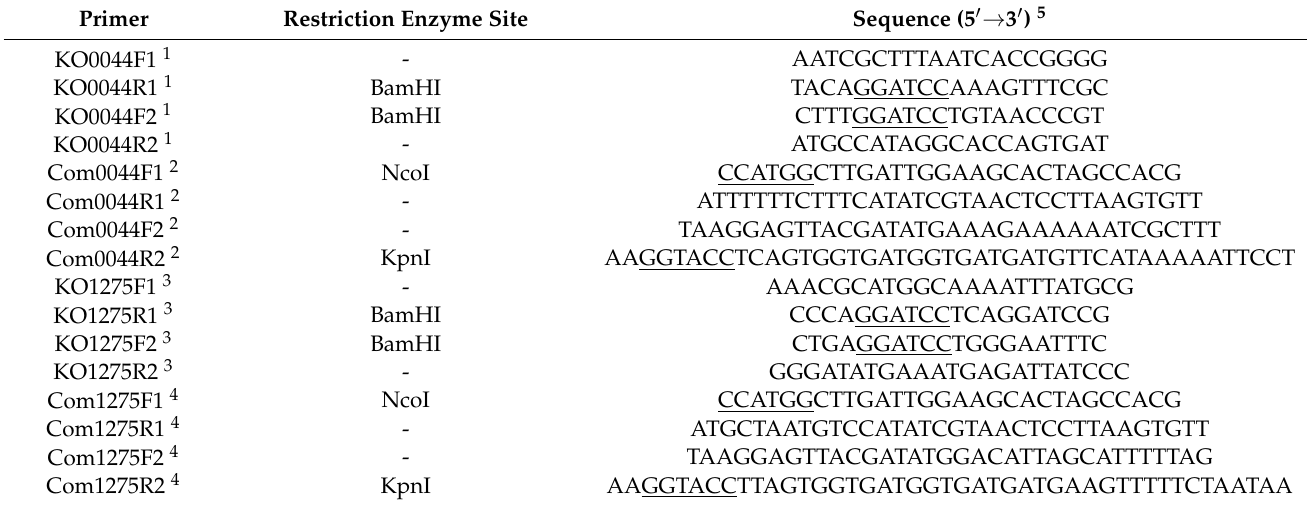
Table 2. Sequences and restriction sites of the primers used in this